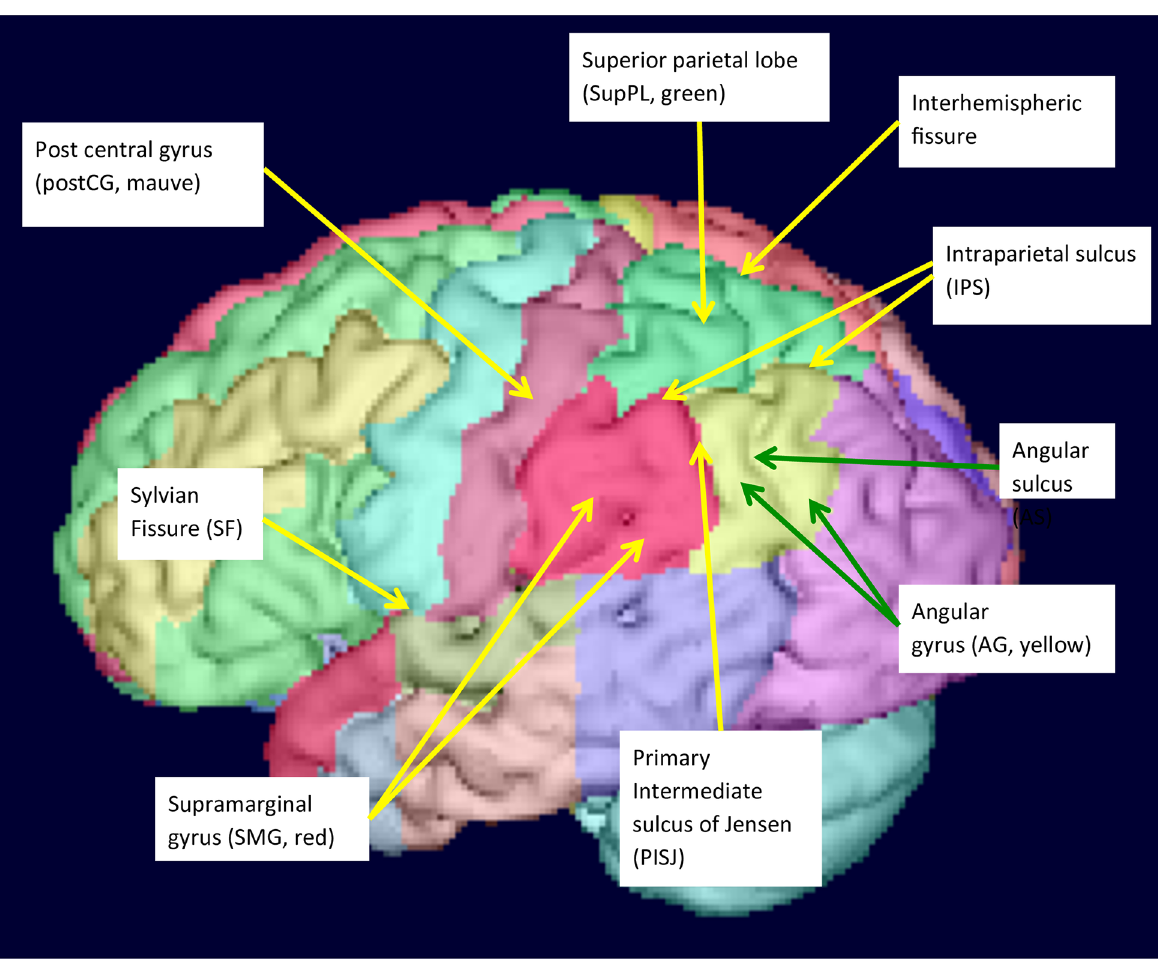
Fig 1. Surface view of parietal lobe